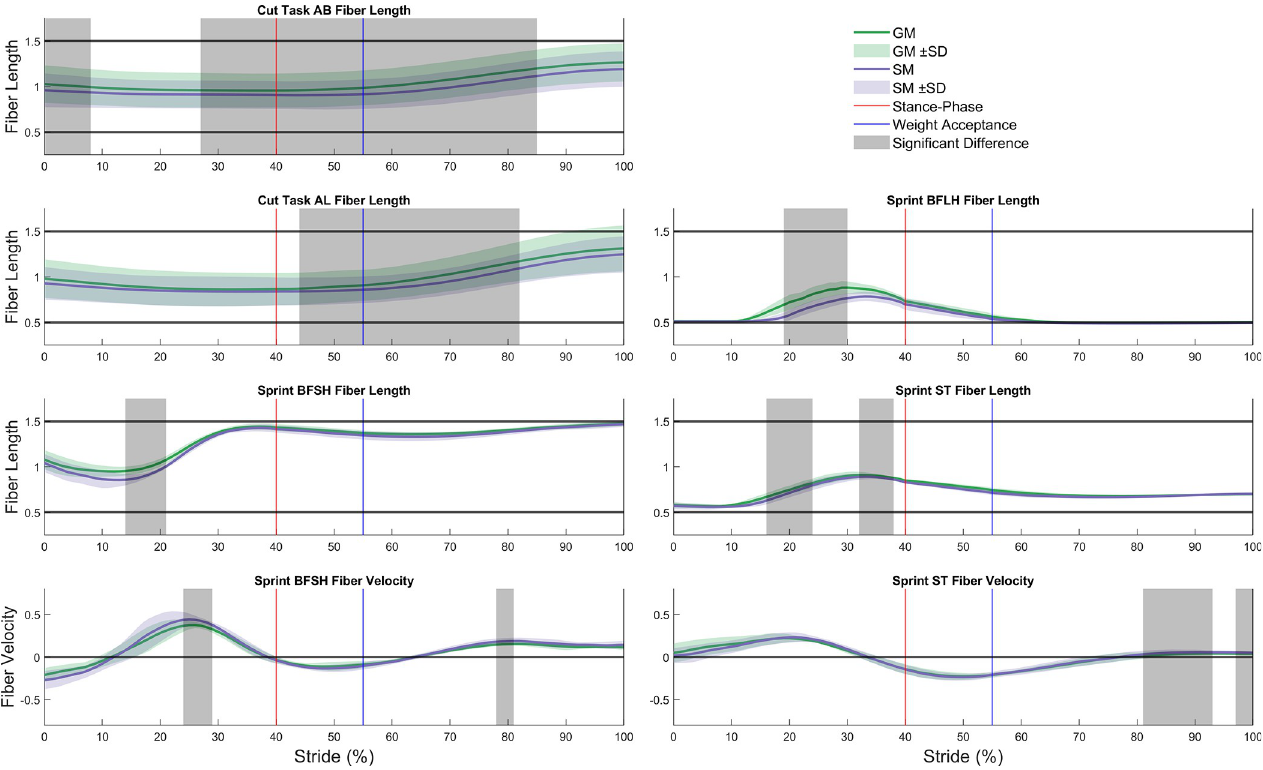
Fig 4. Significant normalized fiber length and velocity differences between generic and subject-specific models. AM, adductor brevis; AL, adductor longus; BFLH, biceps femoris long head; BFSH, biceps femoris short head; ST, semitendinosus; Generic model (GM), subject-specific model (SM), and respective variation between participants as standard deviation. Foot ground contact of the stance limb depicted as the red line. End of weight acceptance phase depicted as the blue line. Areas of significant difference, as determined by statistical parametric mapping (grey). Each muscle’s fiber length was normalized by the respective optimal fiber length and each muscle’s fiber velocity was normalized by the respective maximum shortening velocity.